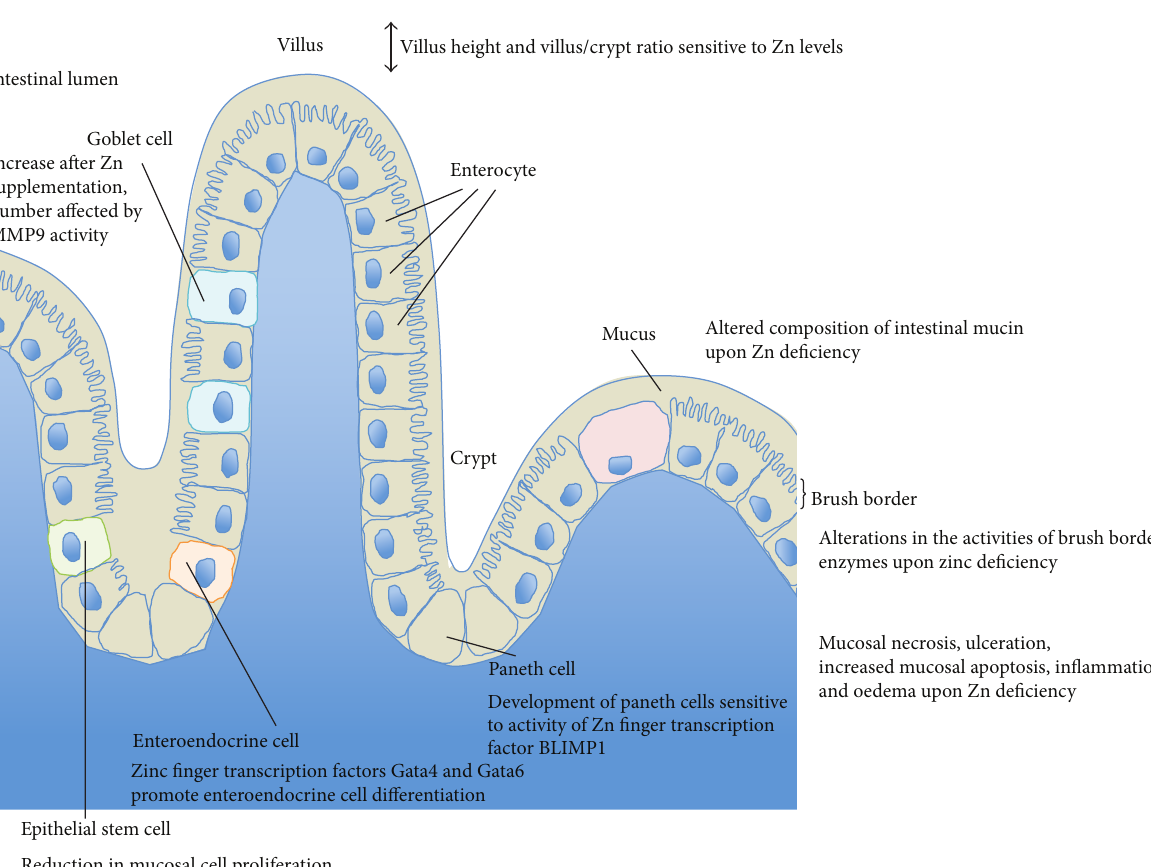
Figure 1: Influence of zinc levels on gut formation. Zinc levels mediate villus height and villus/crypt ratio in the jejunum. Zinc deficiency results in a shortening and narrowing of the villi and thus a reduction in absorptive surface. This may be mediated by a reduction in mucosal cell proliferation and slower cell migration, as well as an increase in the number of apoptotic cells in villi and crypts. The zinc finger transcription factors Gata4 and Gata6 are involved in intestinal epithelial cell differentiation and promote enteroendocrine cell differentiation. Moreover, the number of goblet cells increases after zinc supplementation and is dependent on the activity of the zinc binding matrix metalloproteinase-9 (MMP-9). Goblet cells secrete mucins and an altered composition of intestinal mucin was reported in zinc deficient animals. Additionally, several alterations in the activities of brush border enzymes result from zinc deficiency. The development of paneth cells is accelerated by the zinc dependent transcription repressor BLIMP1. Furthermore, zinc deficiency is accompanied with mucosal necrosis and ulceration, inflammation, and